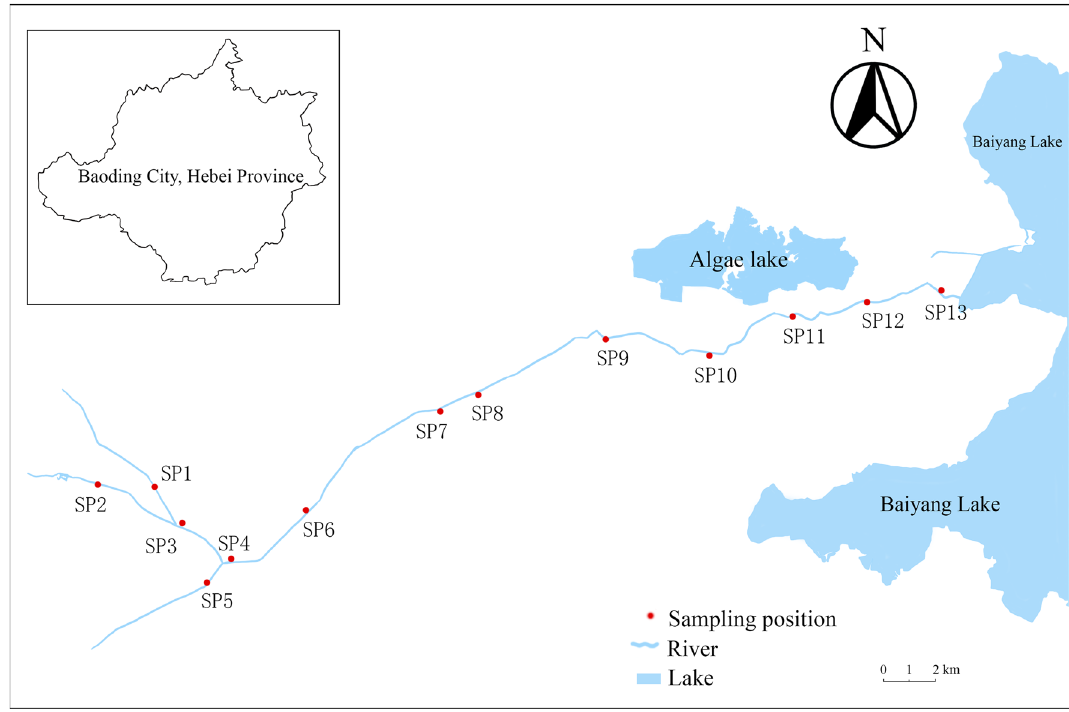
Figure 3. Geographic location map of sampling positions.